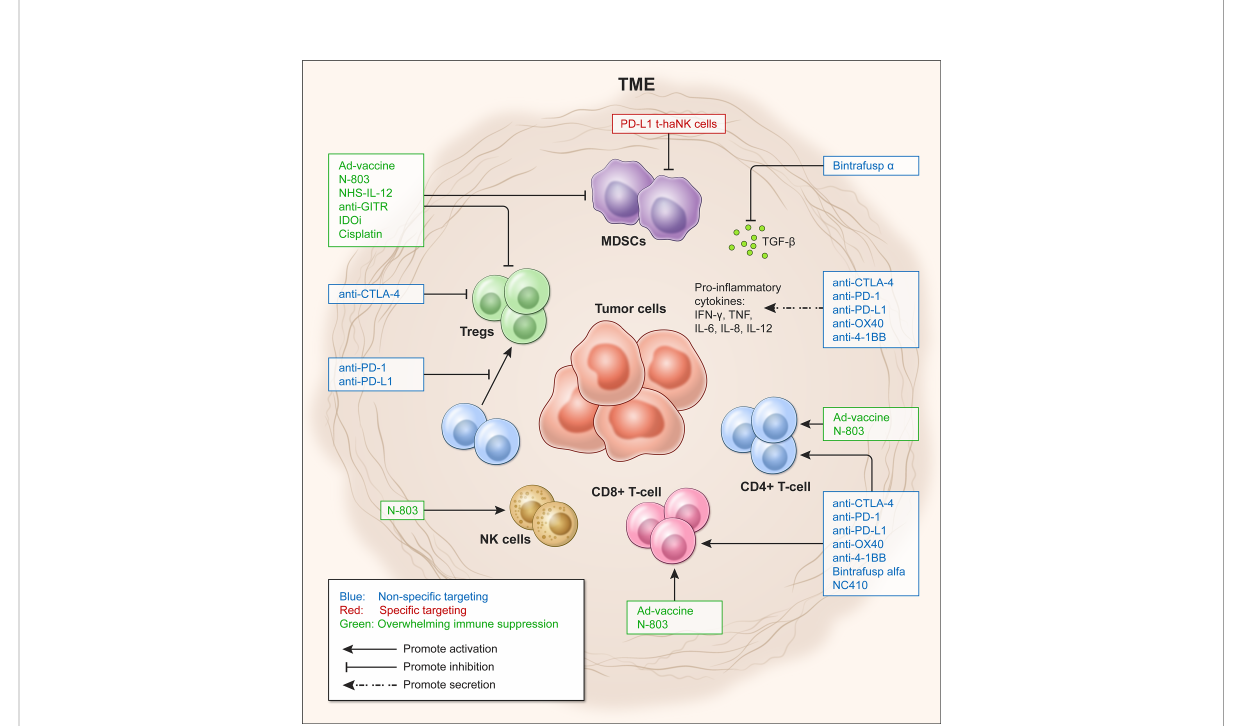
FIGURE 1 Targeting approaches to overcome immune suppression in the tumor microenvironment (TME). Effects of targeting the TME in a non-speci fi c (blue) and speci fi c manner (red), and by shifting Teff/Treg ratio to overcome immunosuppression